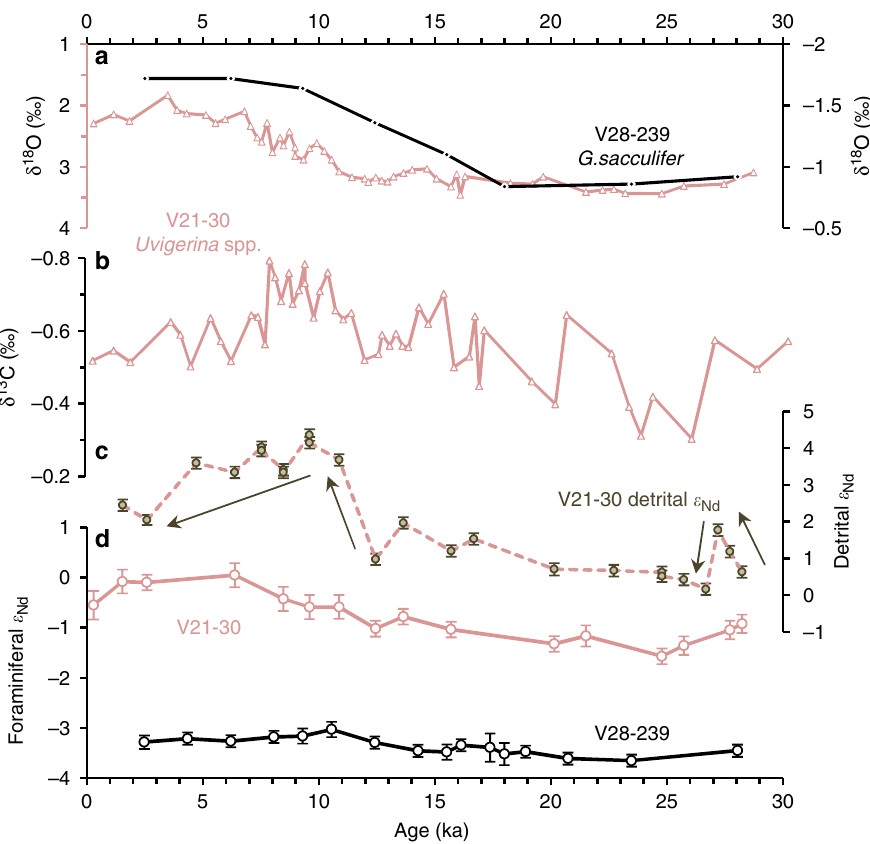
Fig. 2 Deglacial records of core V21-30 and V28-239 (0 – 30 ka). a Benthic δ 18 O of V21-30 (pink) 69 and planktonic δ 18 O of V28-239 (black) 53 . b Benthic δ 13 C of V21-30 (pink) 69 . c Detrital ε Nd record of V21-30 with arrows denoting changing trends over time. d Foraminiferal 239. Error bars correspond to the 2 σ external error of the ε Nd